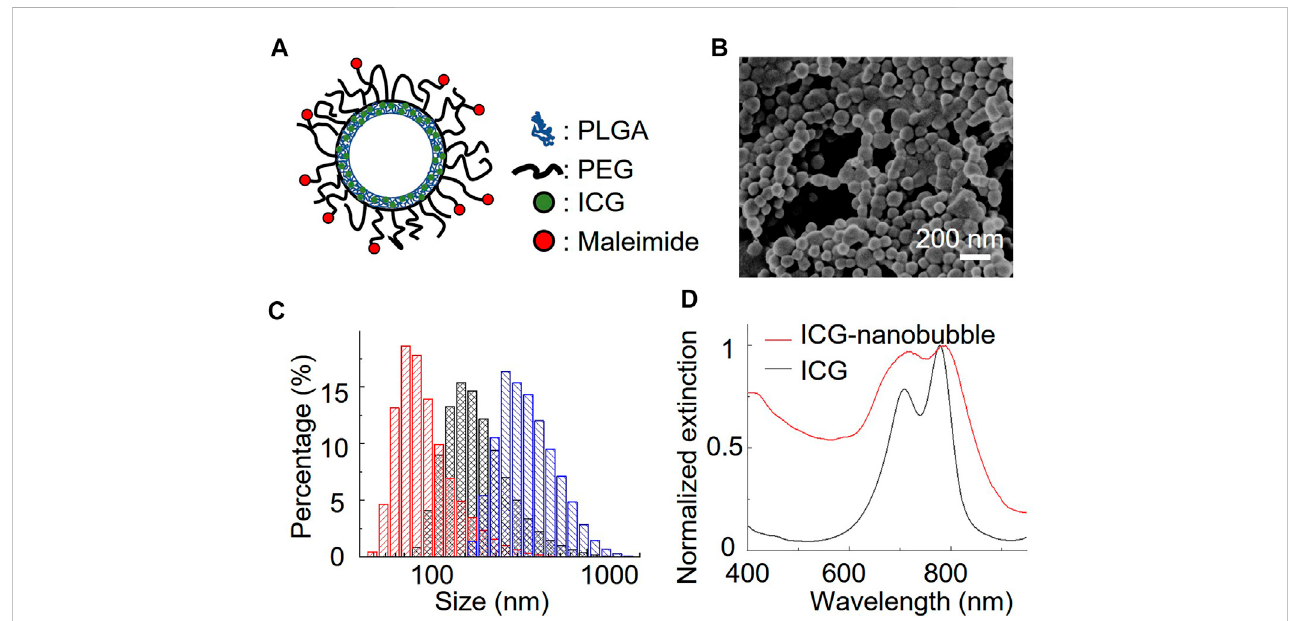
FIGURE 1 Characterization of ICG nanobubbles. (A) The structural illustration of an ICG nanobubble. (B) Environmental-SEM image of ICG nanobubbles (100 nm). (C)